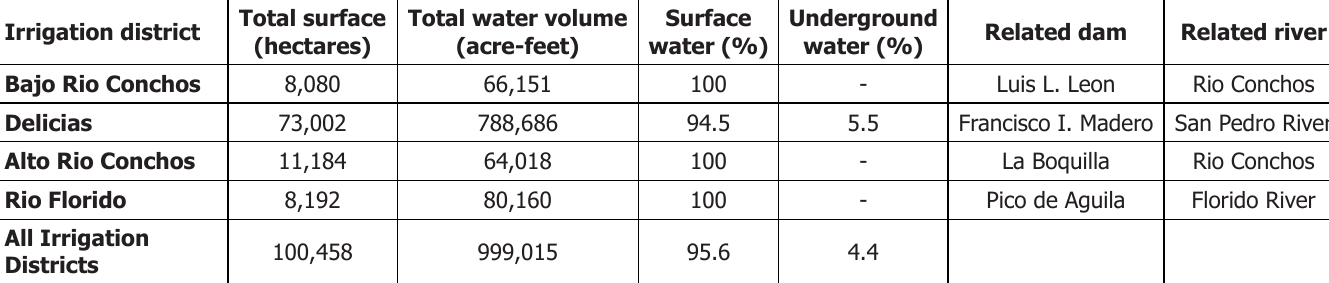
Table 3. Rio Conchos Watershed irrigation districts in agricultural year